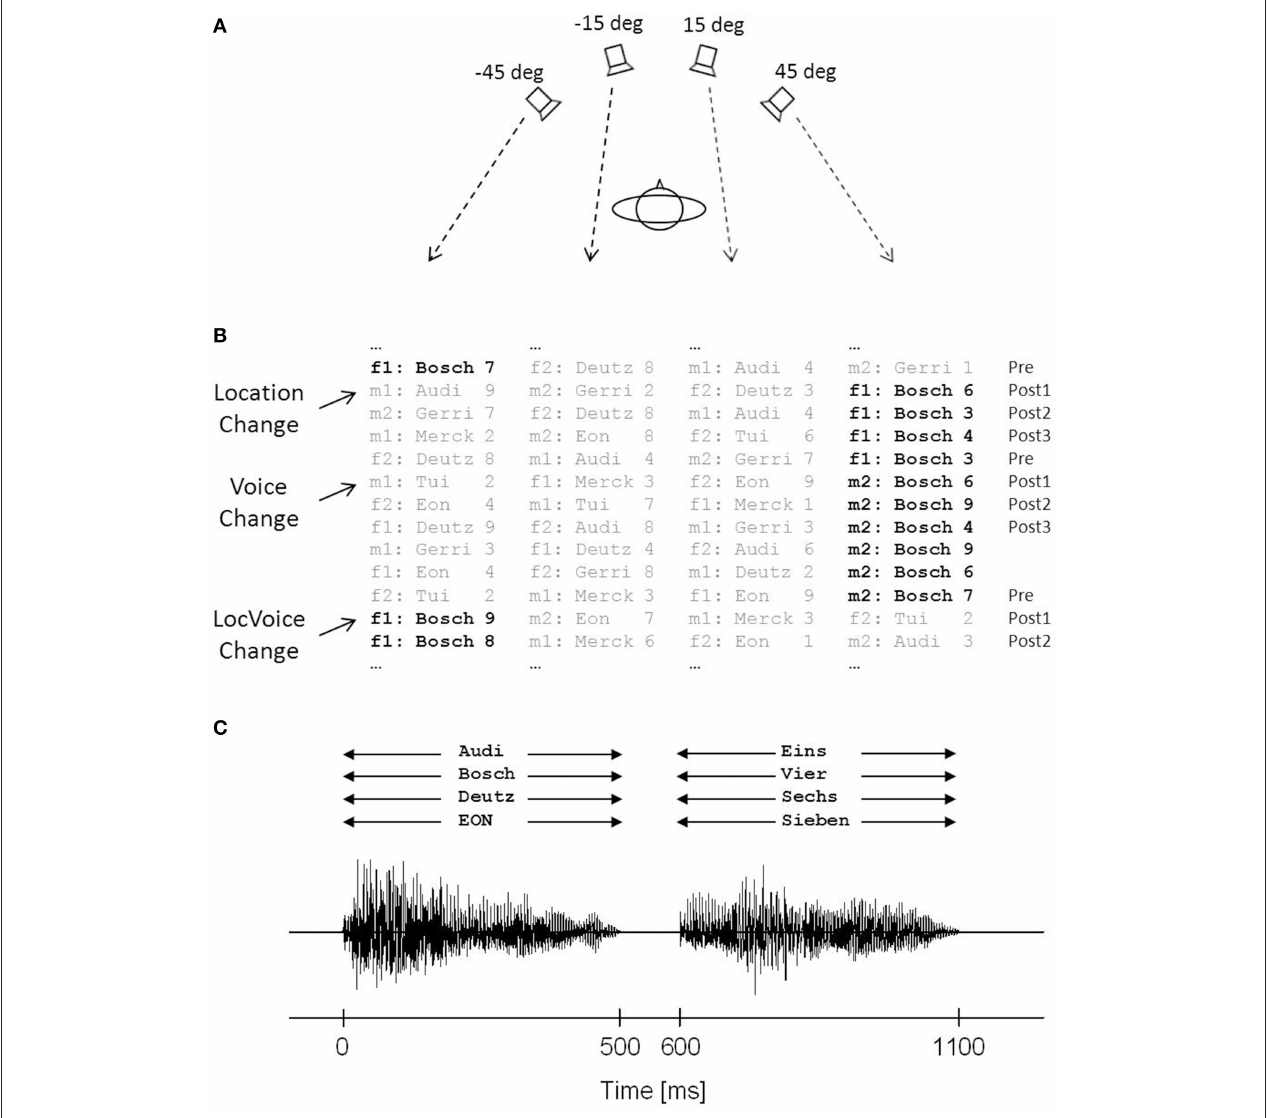
FIGURE 1 | Schematic illustration of the simulated stock-price monitoring scenario. (A) Four loudspeakers were mounted at different locations to the left and right of the subject’s median plane. Stimuli were displayed simultaneously via all loudspeakers. (B) Stimuli were spoken by two female (f1, f2) and two male (m1, m2) speakers and consisted of sequences of short company names and numbers. The participants responded to the value of a given target company (here “Bosch,” in bold print), while all other company names had to be ignored. The location of the target company (Location Change), the speaker voice (Voice Change), or both (LocVoice Change) changed following a pseudo-random scheme. Analyses were focused on sequences preceding (Pre) and following a change trial (Post1, Post2, Post3). (C) Superimposed acoustic waveforms of the four streams of words (here: company names “Bosch,” “Deutz,” “EON,” and “Audi,” and numbers “eins,” “vier,” “sechs,” and “sieben”) presented at different